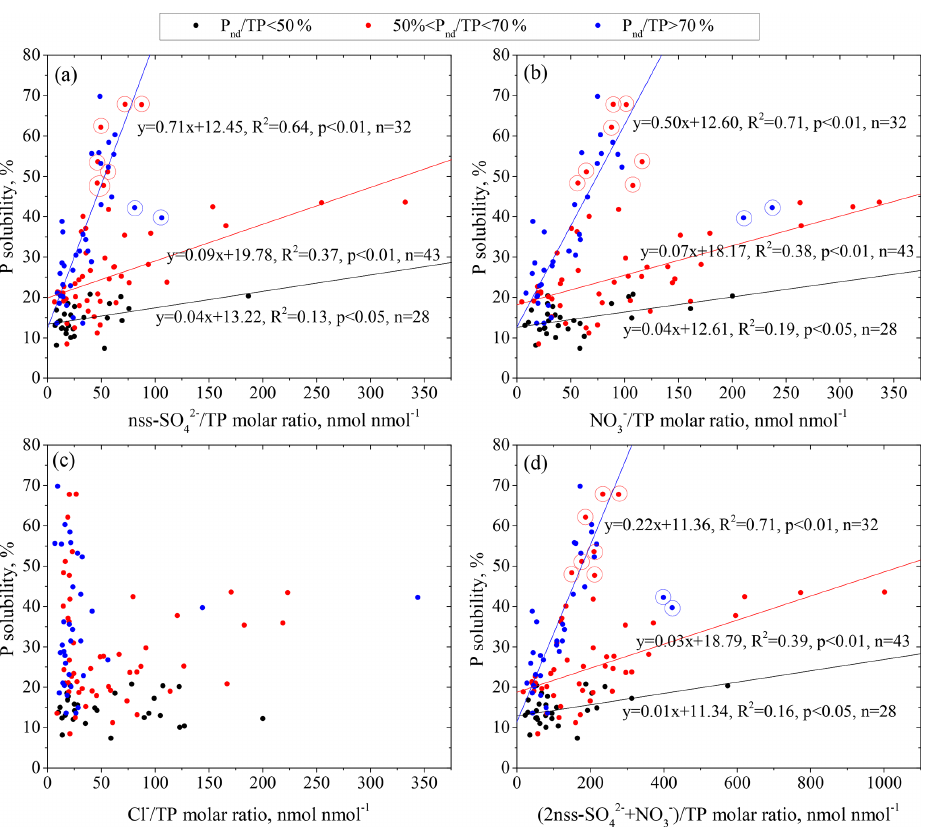
/ TP molar ratio (a) , NO − / TP molar ratio (b) , Cl − / TP molar ratio (c) and 4 3